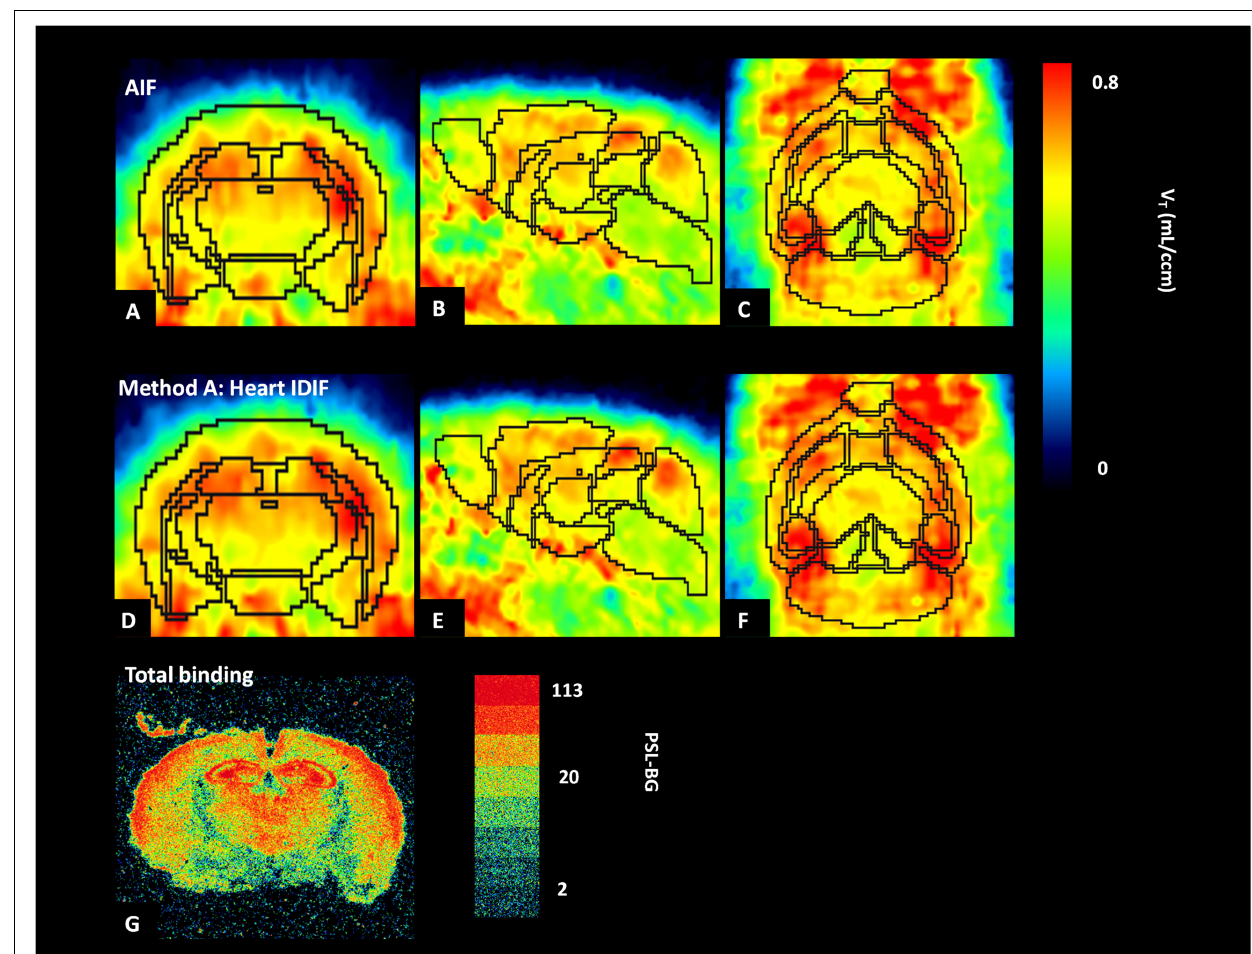
FIGURE 5 | Average parametric images ( n = 5) of A 1 adenosine receptors (A 1 ARs) distribution in mice brains calculated by application of Logan plot in PET: coronal plane (left column), sagittal plane (middle column), and horizontal plane (right column) images representing cerebral A 1 AR using the arterial input function (AIF) (A–C) and the image-derived input function over the heart (heart IDIF) (D–F) . Mouse brain autoradiograph (at 0.99 nM concentration of [ 3 H]CPFPX) shows receptor total binding (G)